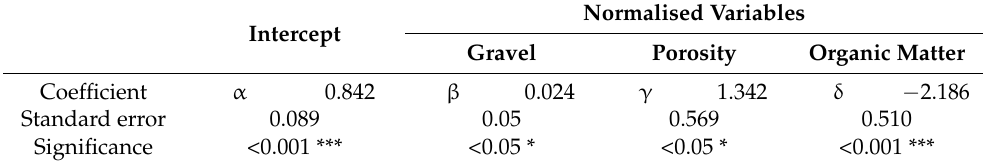
Table 4. Coefficient, standard error, and significance for each variable considered in the multiple linear regression to define the standardised erosion retardation factor ( sERF ). Significance values are as follows: not significant (>0.05), significant (<0.05 *), very significant (<0.01 **), highly significant (<0.001 ***).